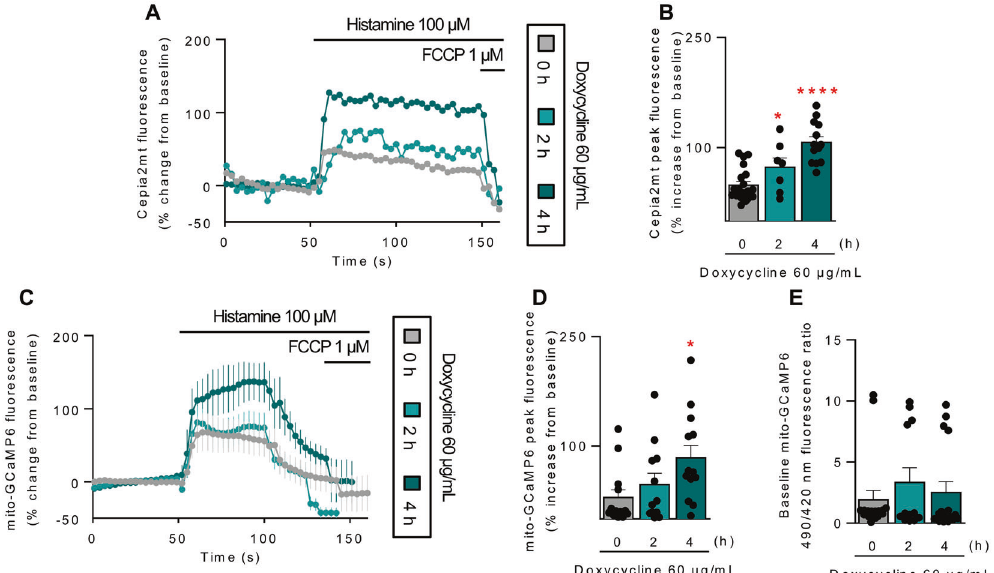
Fig. 3 Doxycycline increases ER-to-mitochondria calcium transfer. A HeLa cells were transfected with the mitochondrial Ca 2 + sensor Cepia2mt for 24 h, then treated with 60 µg/mL doxycycline for the indicated times and imaged using confocal microscopy. Baseline fl uorescence was evaluated, and then Ca 2 + release from ER stores was induced with 100 nM histamine. B Quanti fi cation of Cepia2mt peak fl uorescence of graphs obtained in panel ( A ). For each independent imaging experiment, 7 − 20 cells were analyzed. C HeLa cells were transfected with the ratiometric mitochondrial Ca 2 + sensor mito-GCaMP6 for 24 h, then treated with 60 µg/mL doxycycline for the indicated times and imaged using confocal microscopy. Baseline fl uorescence was evaluated, and then Ca 2 + release from ER stores was induced with 100 nM histamine. D Quanti fi cation of mito-GCaMP6 peak fl uorescence of graphs obtained in panel ( C ). E Quanti fi cation of mito-GCaMP6 basal fl uorescence of graphs obtained in panel ( C ). For each independent imaging experiment, 12 – 17 cells were analyzed. Results are shown as mean ± s.e.m. * P < 0.05 and *** P < 0.001 versus control